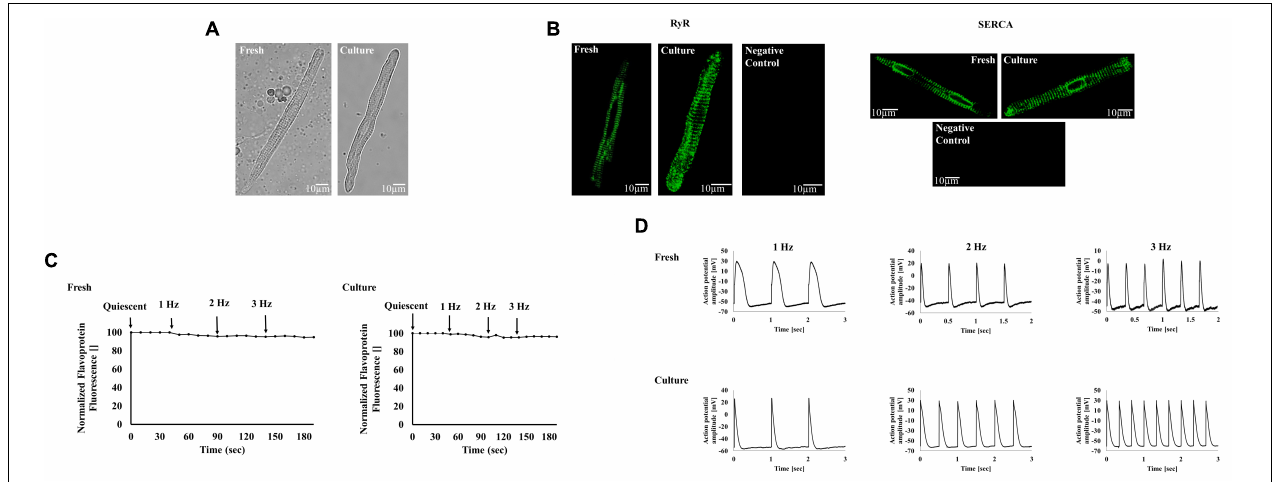
FIGURE 3 | Atrial cell culture. (A) Representative examples of fresh and cultured atrial cells. (B) Ryanodine and SERCA immunolabeling for fresh and cultured atrial cells’ structures. (C) Representative examples of fresh and cultured atrial cell flavoprotein auto-fluorescence in response to increasing electrical stimulation (1–3 Hz). (D) Representative examples of fresh and cultured AP in atrial cells at 1–3 Hz of external electrical stimulation. Data from Kirschner-Peretz et al. (2017). Animals were treated in accordance with the Technion Ethics Committee. The experimental protocols were approved by the Animal Care and Use Committee of Technion (Ethics number: IL-118-10-13). (C) is reproduced from Kirschner-Peretz et al. (2017) with permission.